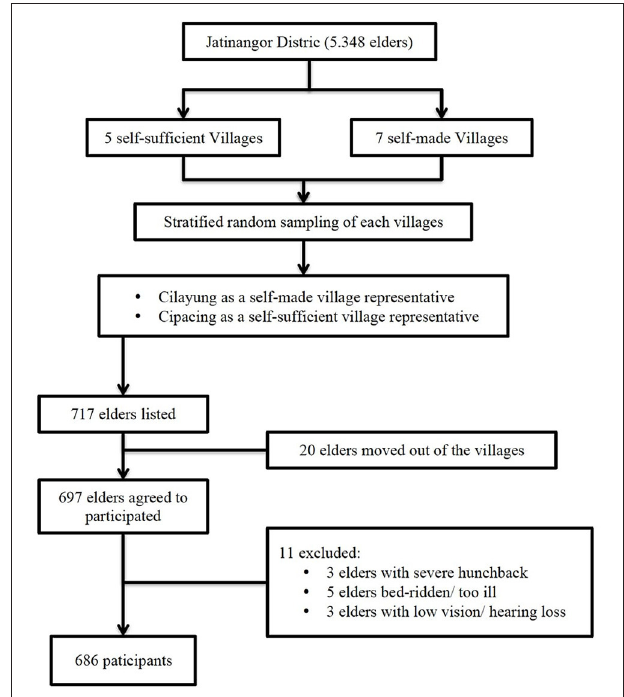
FIGURE 1 | Flowchart describing flow of the participant recruitment in the